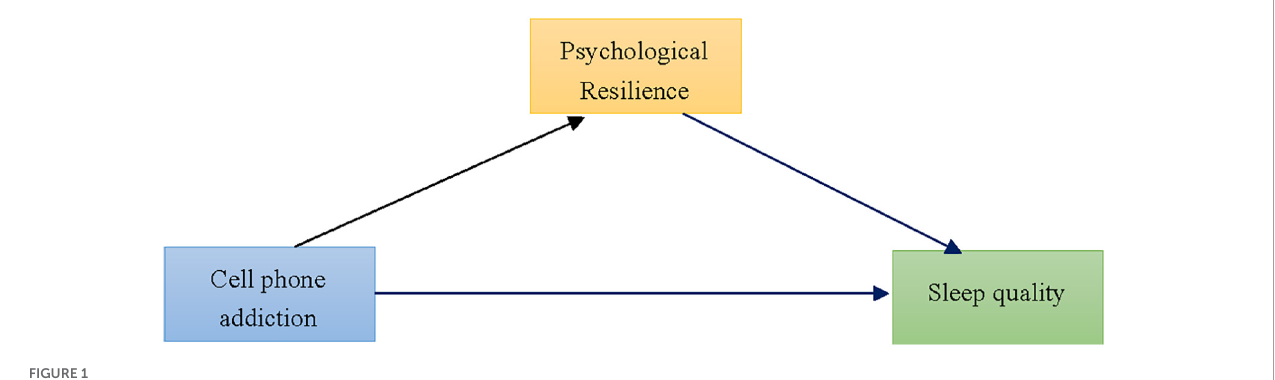
FIGURE1 The proposed mediation